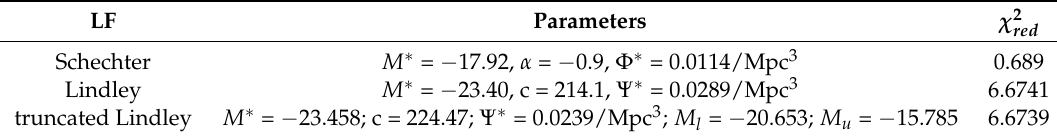
Table 3. Numerical values values and χ 2 of the LFs applied to SDSS Galaxies in the u ∗ band. red LF Parameters χ 2